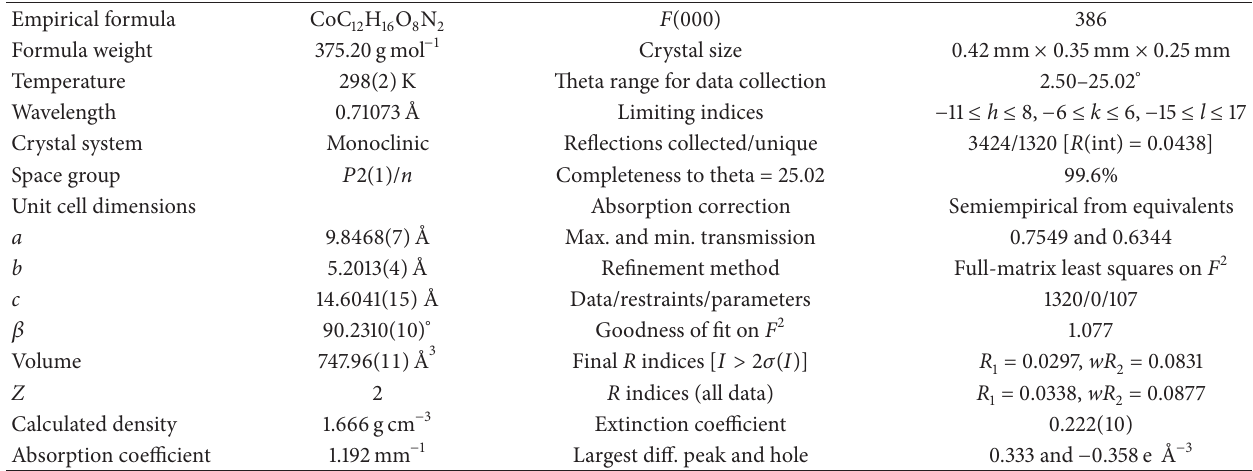
Table 1: Crystal data and structure refinement parameters for the title